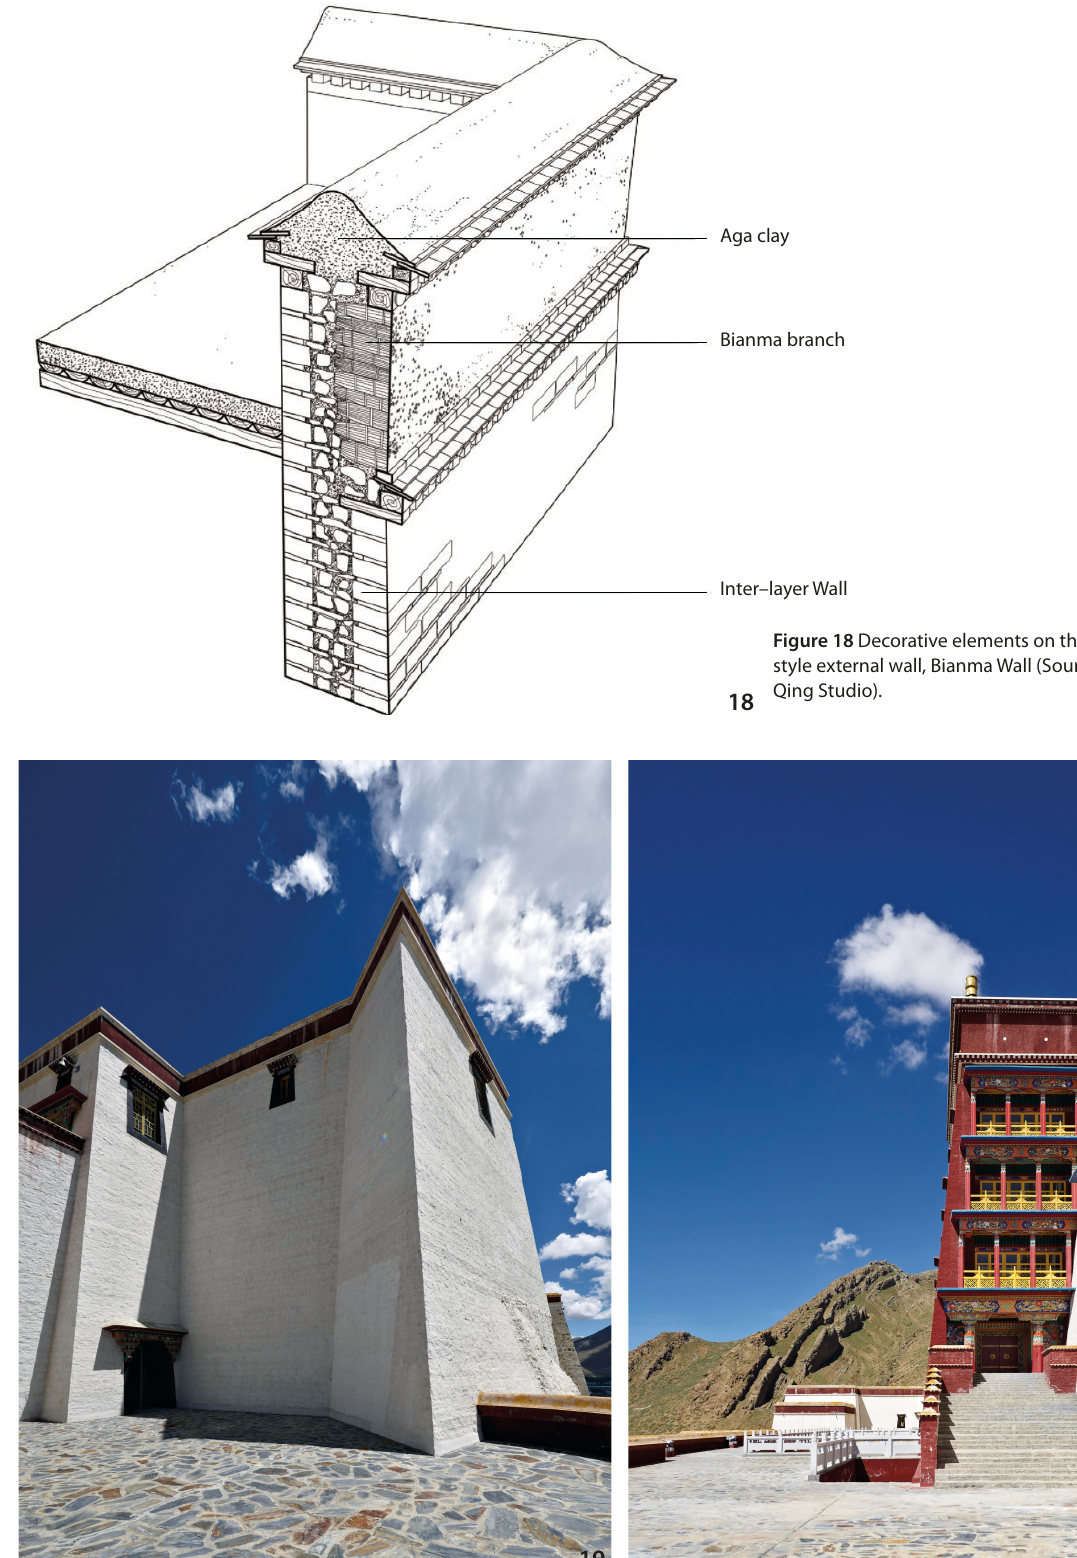
Figure 19 The southeast corner of the white palace of the Sangzhutse Fortress after restoration (Source: Zhang Siye). Figure 20 Entrance of the red palace of Sangzhutse Fortress after restoration (Source: Zhang Siye).